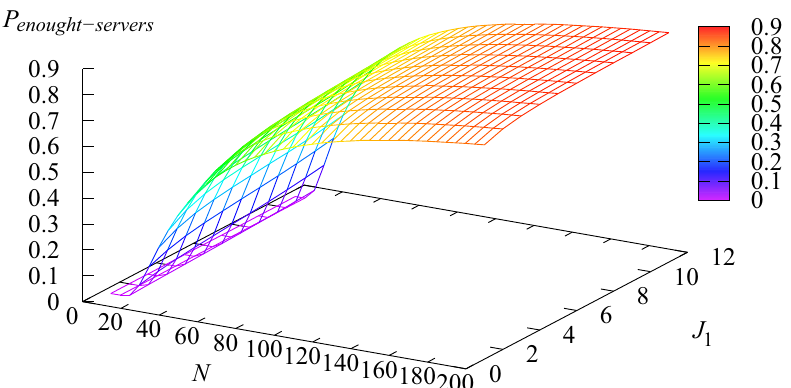
Figure 6. Dependence of the probability P enough - servers on N and J 1 .